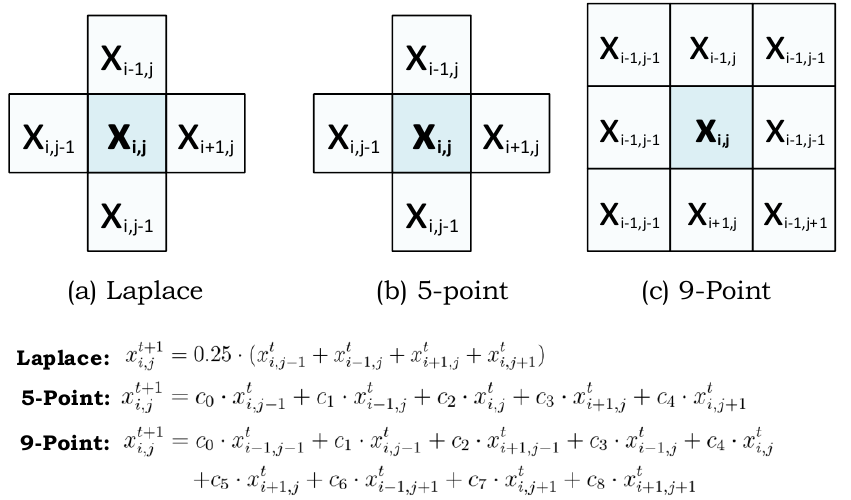
Figure 3. Three types of 2D stencil codes (Laplace, 5-point, and 9-point) together with their corresponding equations and computation